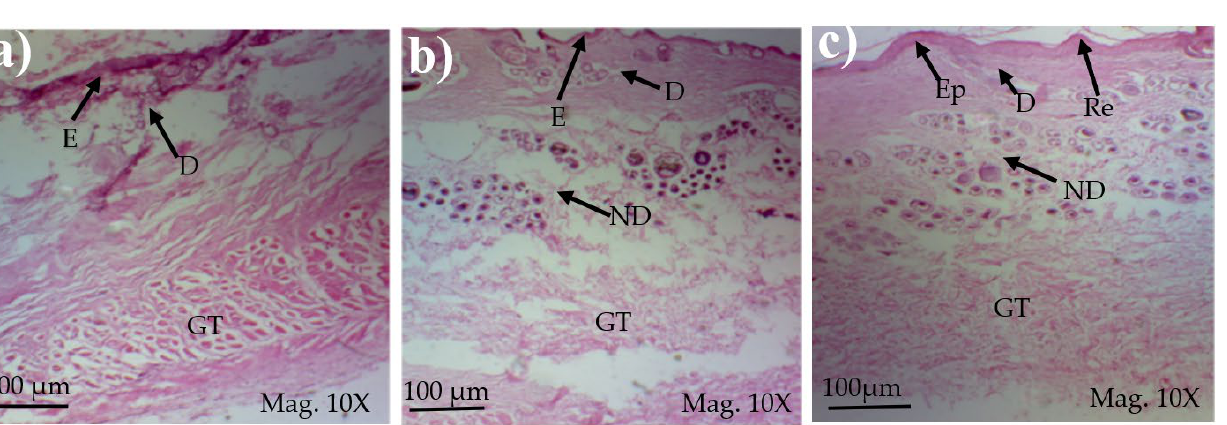
Table 9. Mean thickness of epidermis and dermis ( µ m), and collagen content percentage (%), * TA proved as significant ( p < 0.05)